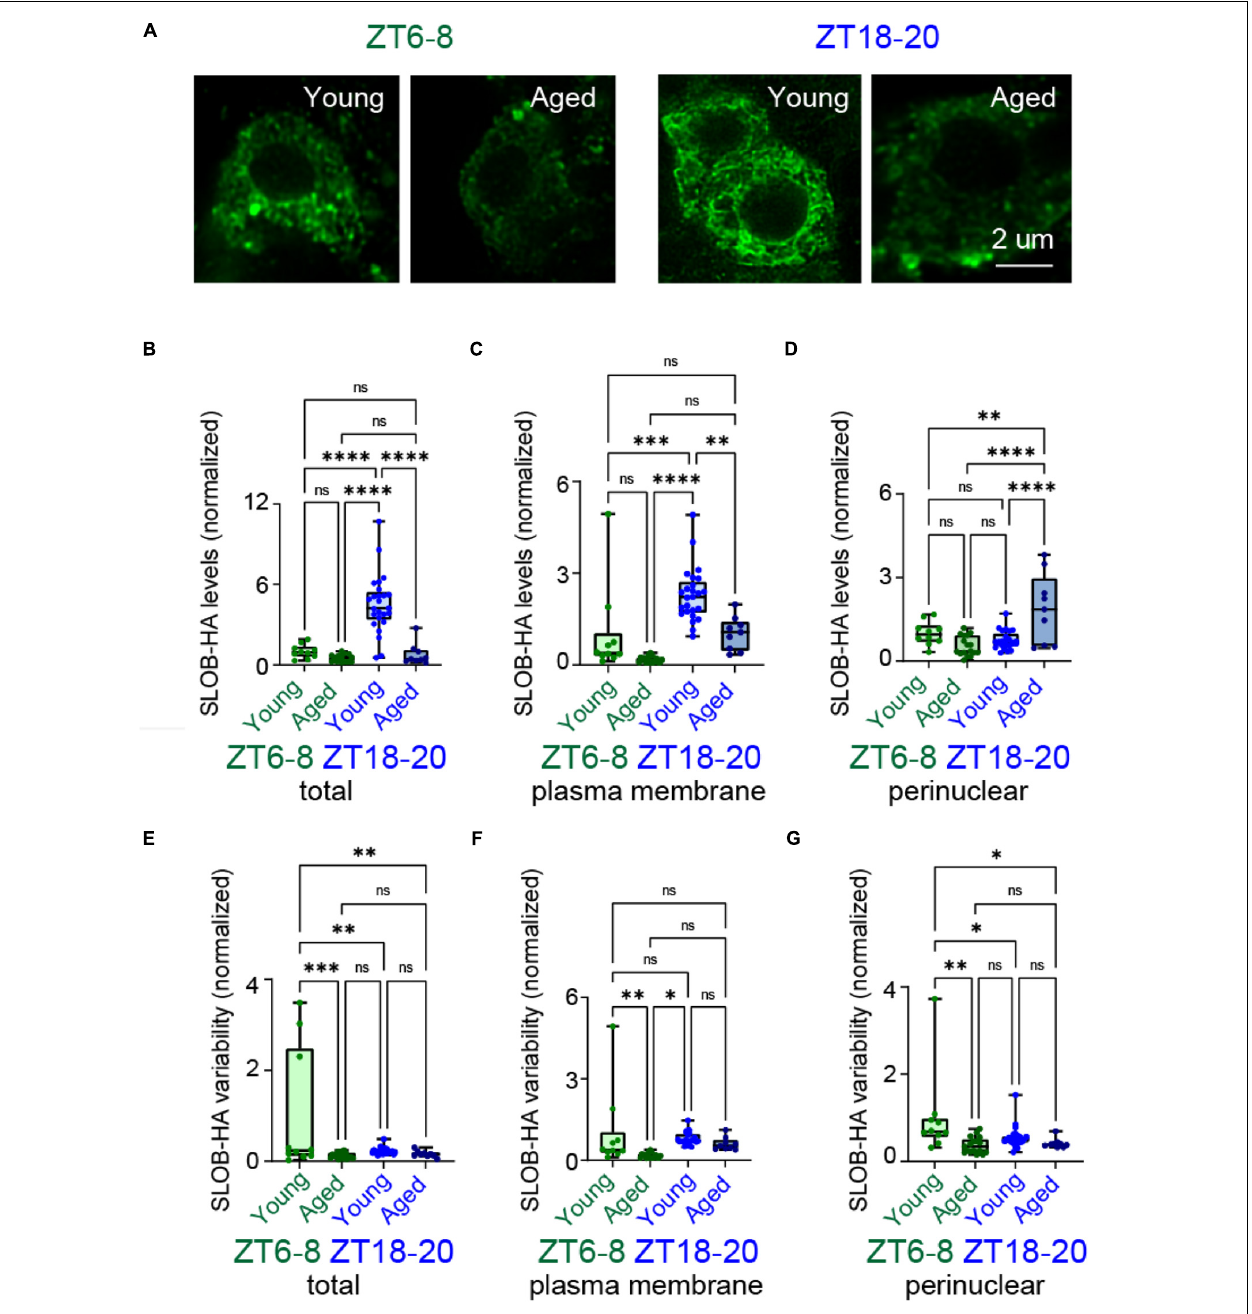
FIGURE 5 | Aging changed time-dependent localization patterns of SLOB in DN1p neurons. (A) Anti-HA (green) immunostaining of DN1p neurons in young and aged wake-GAL4 > UAS-SLOB-HA flies at ZT6–8 and ZT18–20. Scale bar indicates 2 µ m. (B–D) Quantification of total (B) , plasma membrane (C) , and perinuclear (D) SLOB-HA levels in young vs. aged DN1p neurons at ZT6–8 and ZT18–20. (E–G) Quantification of distribution variability for total (E) , plasma membrane (F) , and perinuclear (G) SLOB-HA signals in young vs. aged DN1p neurons at ZT6–8 and ZT18–20 (ZT6–8, young: n = 10, aged: n = 17; ZT18–20, young: n = 25, aged: n = 9). ∗ p < 0.05, ∗∗ p < 0.01, ∗∗∗ p < 0.001, and ∗∗∗∗ p < 0.0001 based on two-way ANOVA with multiple comparisons.